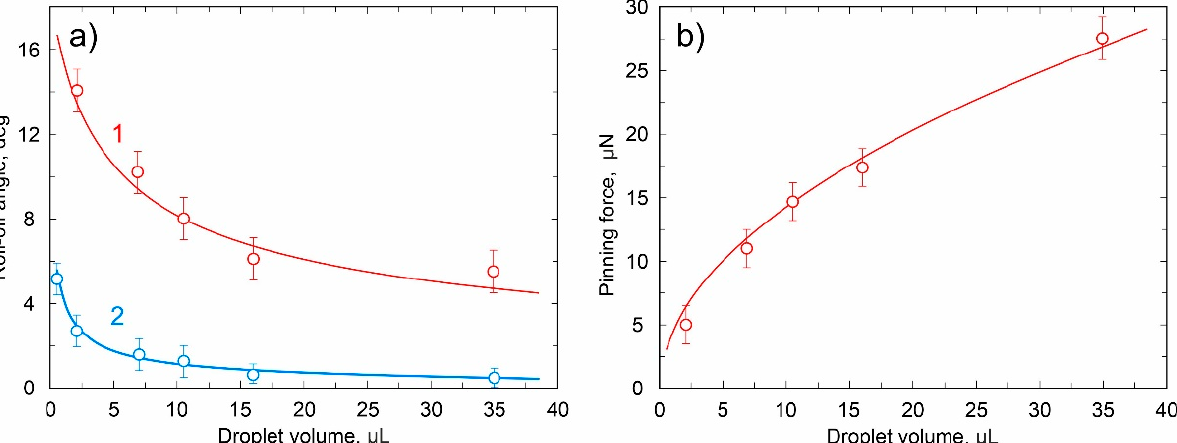
Figure 3. Change in the pinning properties of a superhydrophobic surface caused by the use high voltage on PMD; ( a ) experimental dependence of the roll-off angle on the droplet volume, (curve 1)—modified by EWOD, (curve 2) roll-off angle on an electrically neutral surface; ( b ) dependence of the modified pinning force on the volume of the droplet.